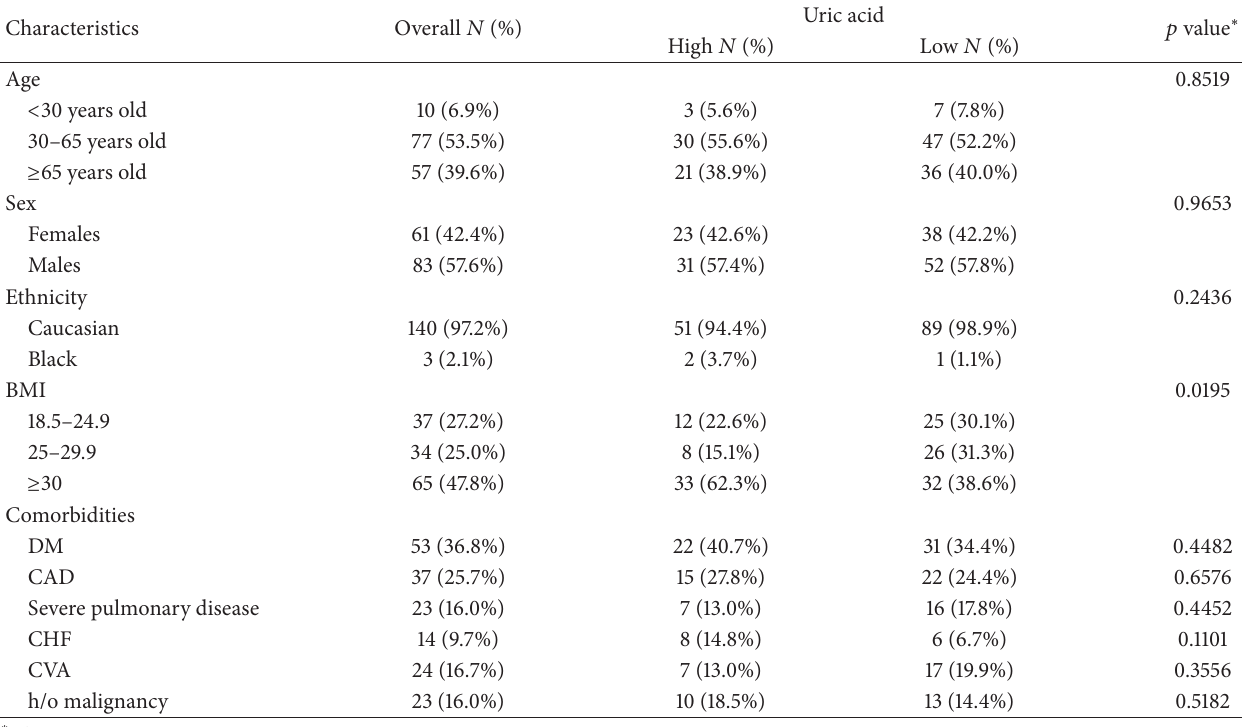
Table 1: Baseline characteristics.